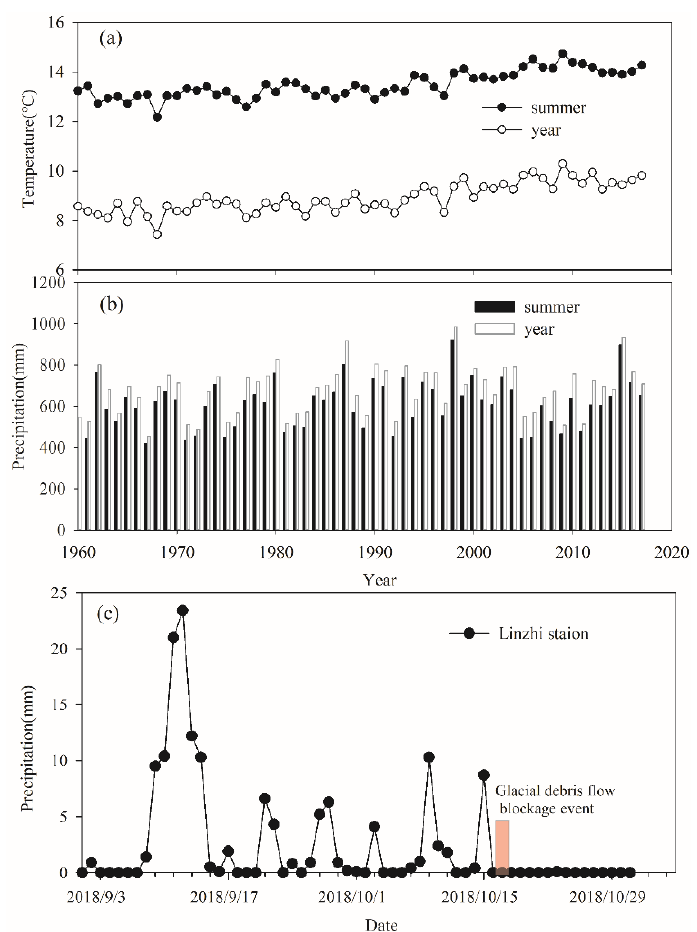
Figure 5. The variations in annual temperature and summer temperature ( a ); annual precipitation and summer precipitation ( b ); and daily precipitation before and after the glacial/rock debris flow event ( c ). All data are sourced from the Linzhi meteorological station.